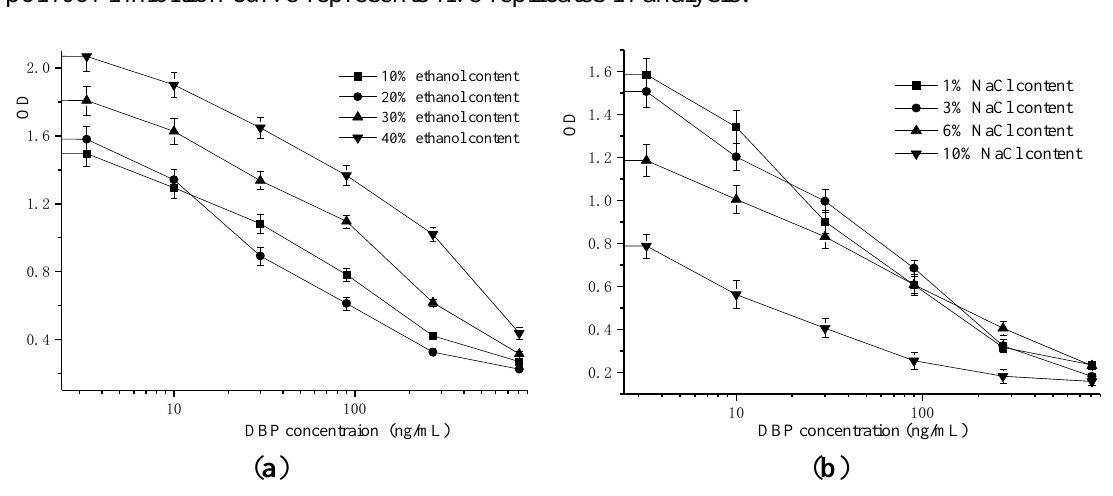
Figure 1. Optimization of assay buffer for ELISA system. ( a ) Effects from ethanol content on performance of ELISA; ( b )-Effects from NaCl content on performance of ELISA. Each point of inhibition curve represents five replicates in